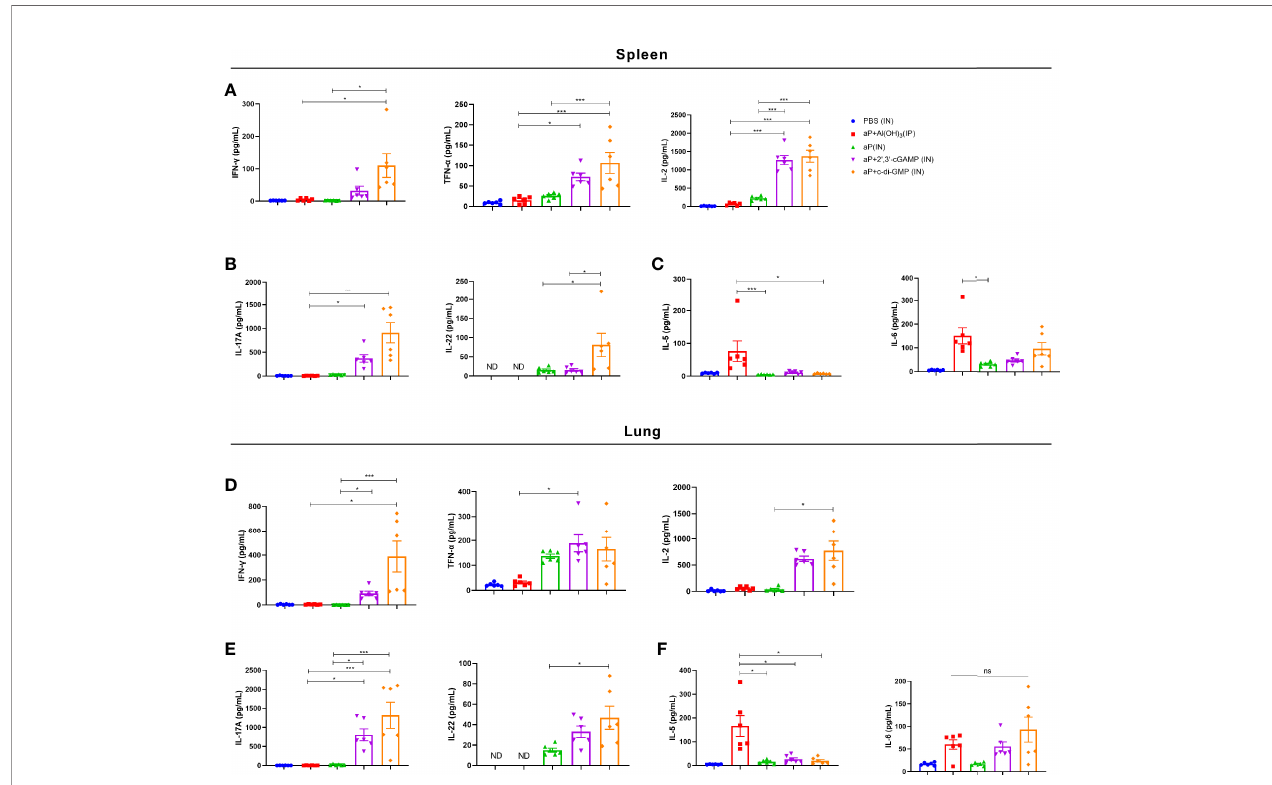
FIGURE 5 | c-di-GMP-adjuvanted aP enhances the expression of Th1/Th17-related cytokines in both splenic and pulmonary lymphocytes. Two weeks after the third immunization, splenic and pulmonary lymphocytes were isolated. Cells were cultured at a concentration of 2 × 10 6 /ml at 37°C with 5% CO 2 and stimulated with the B. pertussis- speci fi c antigens PT (2 m g/mL), FHA (2 m g/mL), and PRN (2 m g/mL). After incubation for 3 days, the culture supernatant was collected, and multiple cytokines were assayed by ELISA. (A) Th1 response-associated cytokines (IFN- g , TNF- a , and IL-2), (B) Th17 response-associated cytokines (IL-17A and IL-22), and (C) Th2 response-associated cytokines (IL-5 and IL-6) in the culture supernatant of splenic lymphocytes. (D) Th1 response-associated cytokines (IFN- g , TNF- a , and IL-2), (E) Th17 response-associated cytokines (IL-17A and IL-22), and (F) Th2 response-associated cytokines (IL-5 and IL-6) in the culture supernatant of pulmonary lymphocytes. Data are expressed as the mean ± SEM. “ ND ” indicates that no individuals in this group had detectable levels. Statistical differences between the results of vaccine-immunized groups and those of the PBS group are not marked. The P value is indicated as follows: * P < 0.05, ** P < 0.01, *** P < 0.001, ns, no signi fi cance